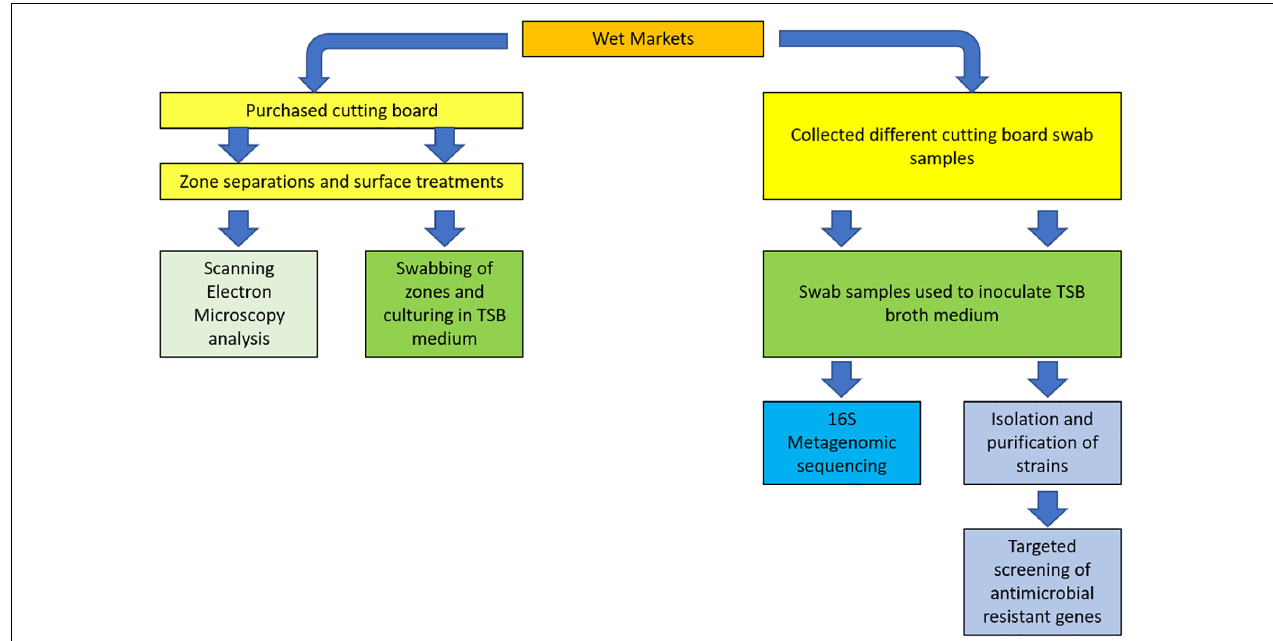
FIGURE 1 | Schematized summary of study